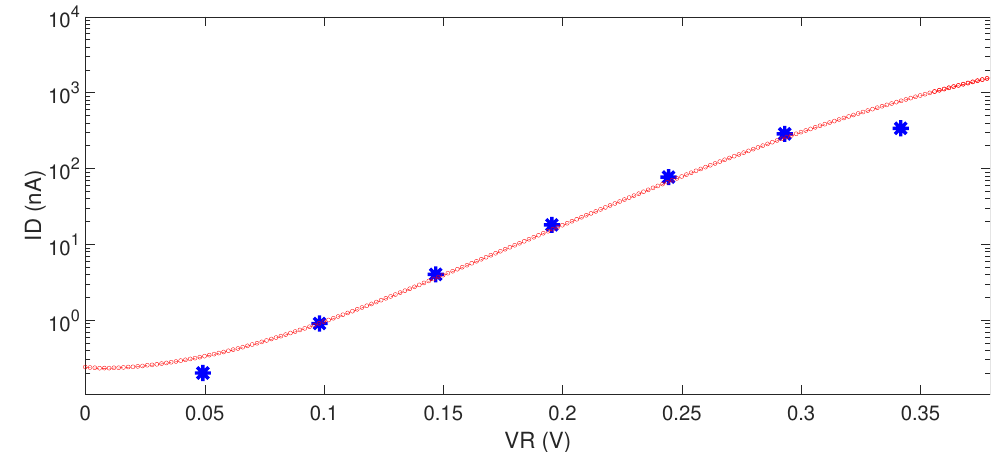
Figure 13. Comparison between the measurements acquired from a semiconductor parameter analyzer and ANTIGONE ASIC when the V R voltage is changing. The red points show the current measured with the parameter analyzer, and the blue points the current using the ANTIGONE